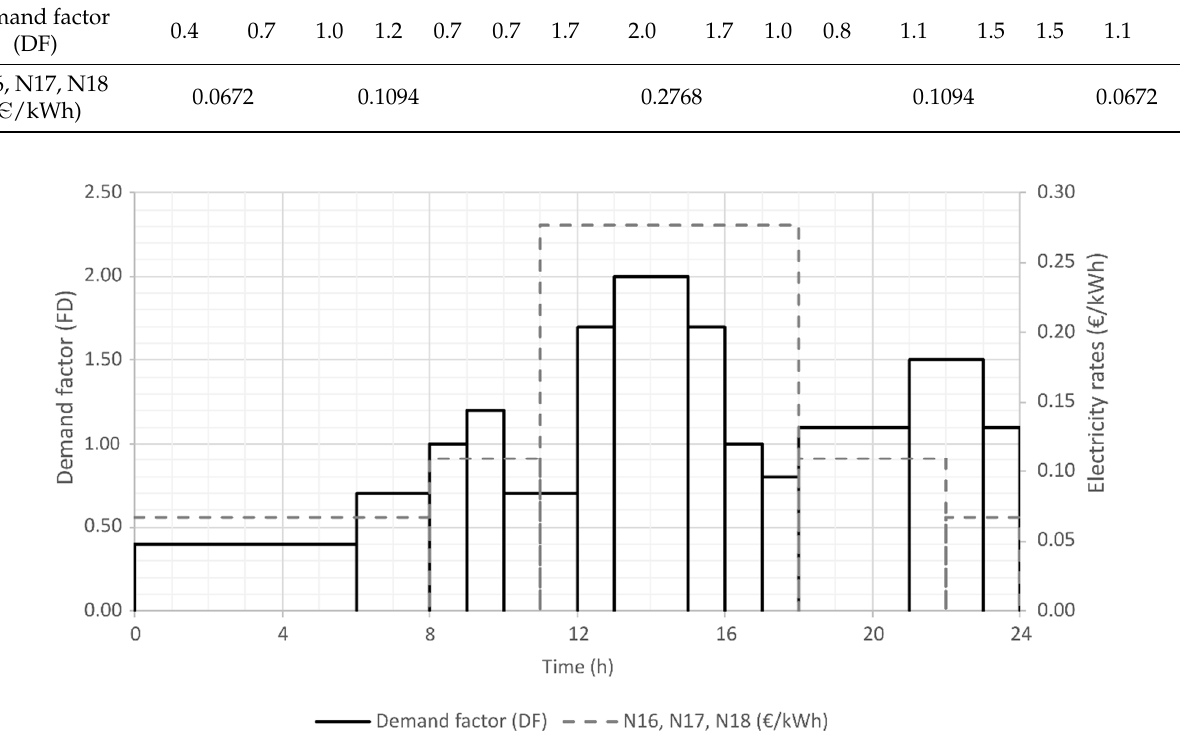
Table 3. Demand curve and electricity rates.